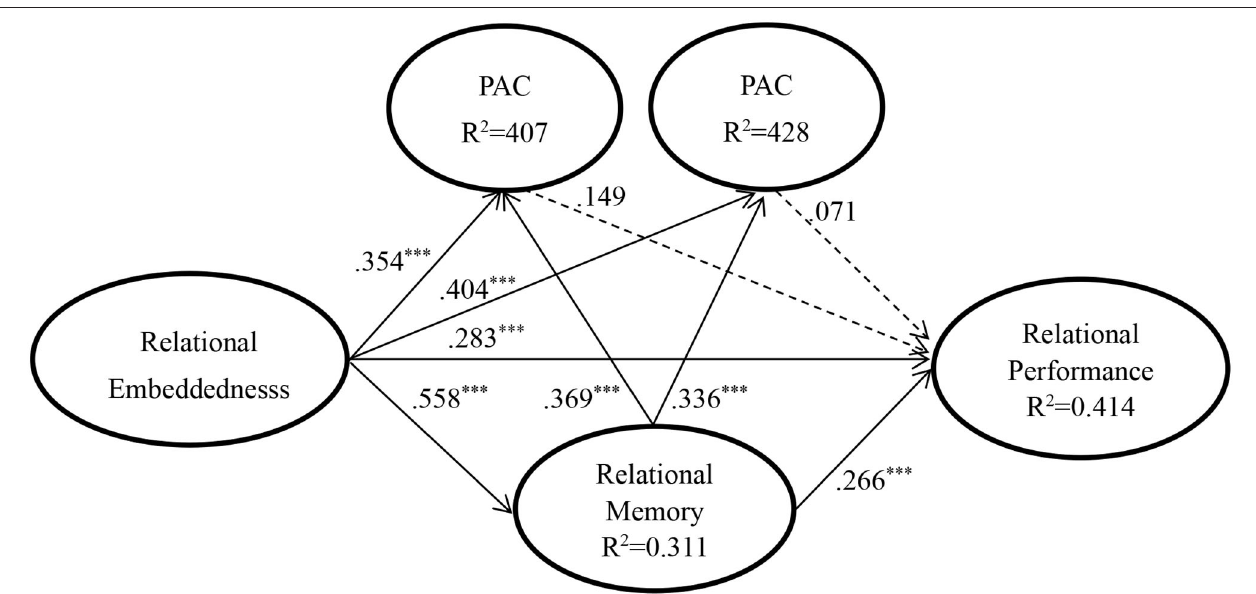
FIGURE 2 | Structural model. *** p < 0.001.